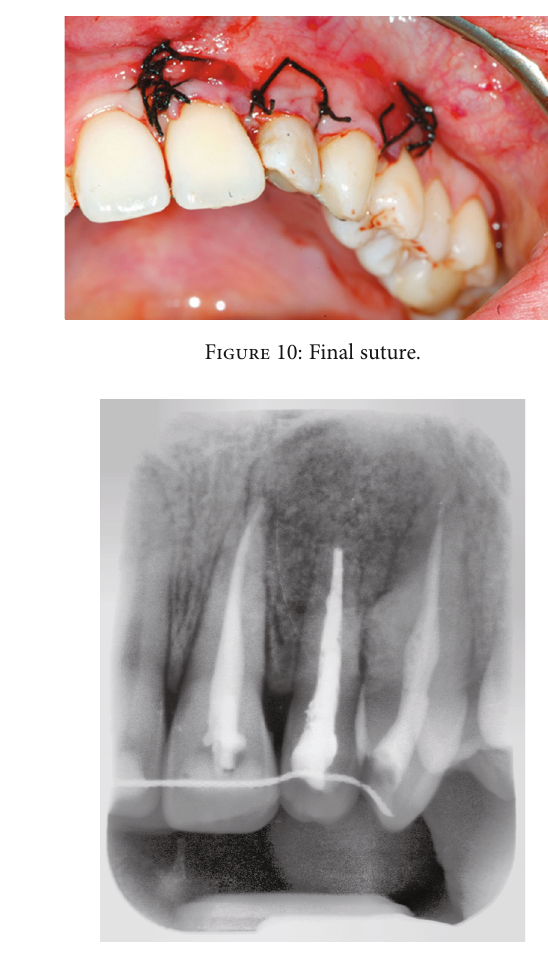
Figure 11: Postoperative